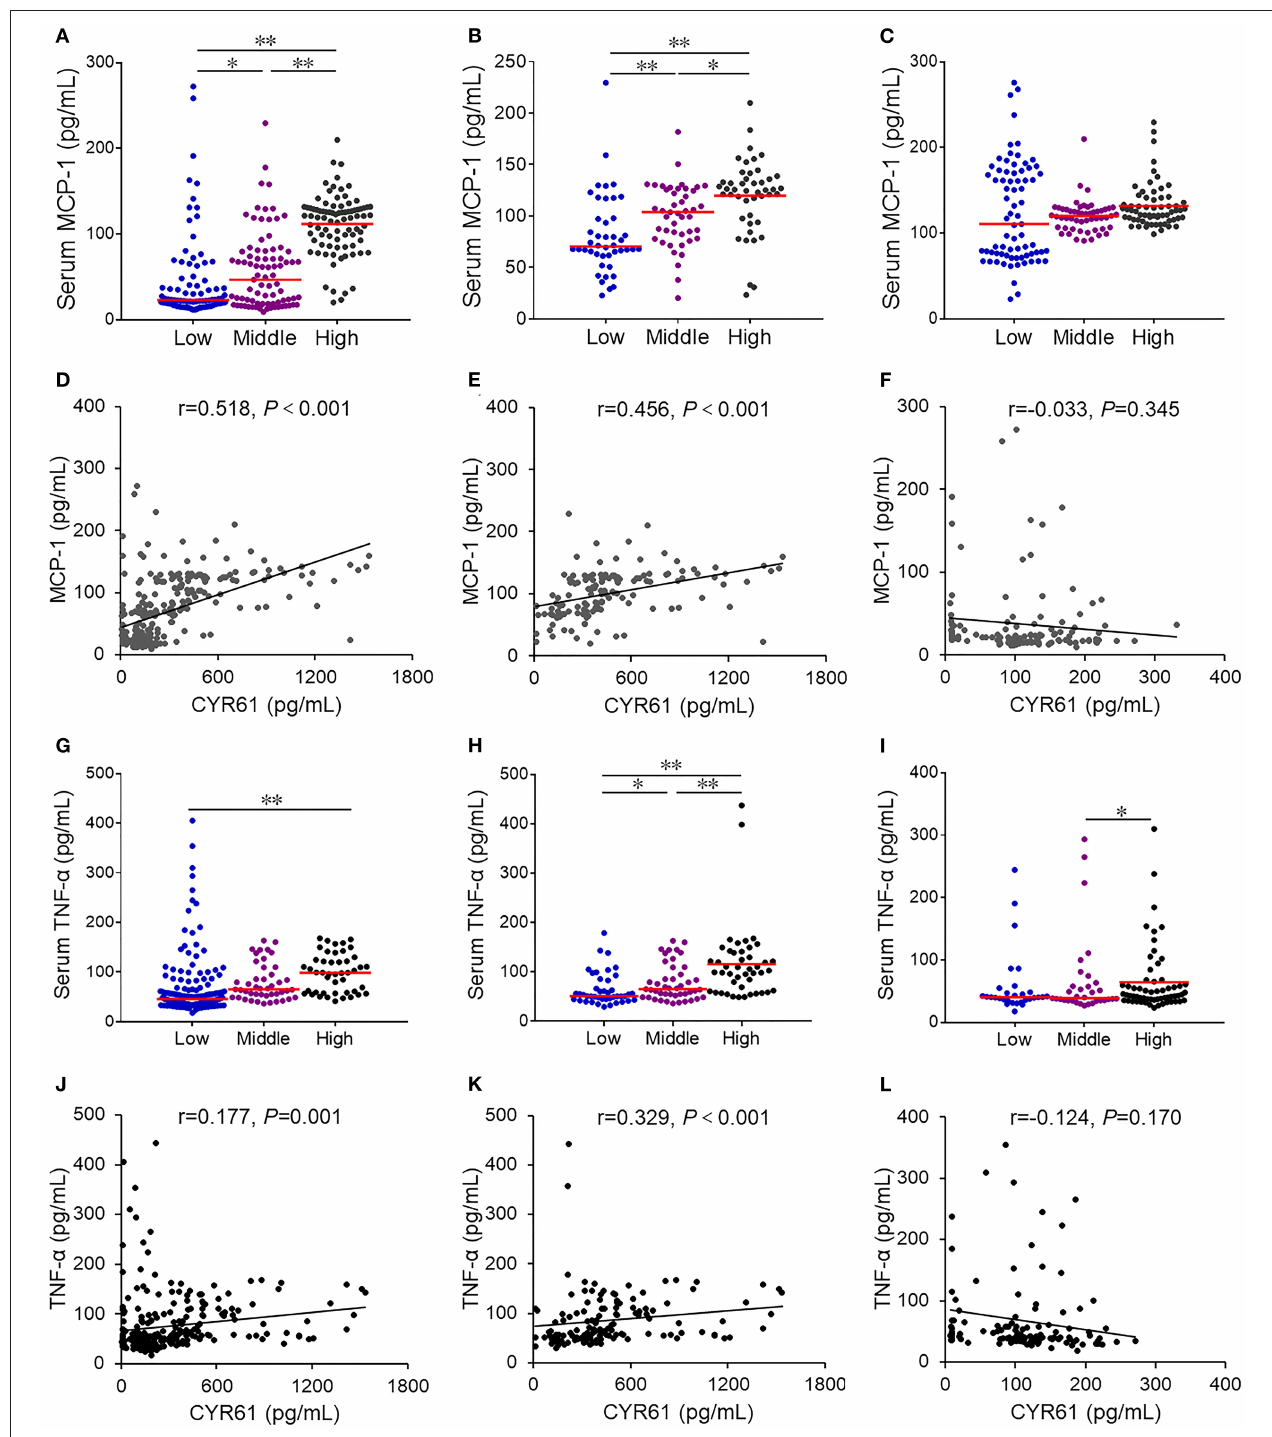
FIGURE 4 | The association of serum CYR61 level with serum inflammatory cytokines in COPD patients. Sera were collected from 150 COPD patients and 150 control subjects. Serum CYR61 and inflammatory cytokines were detected using ELISA. (A,D) Association between serum CYR61 and MCP-1 was analyzed among all subjects. (A) Serum MCP-1 was compared among subjects with different levels of CYR61. (D) Correlation analysis between serum CYR61 and MCP-1. (B,E) Association between serum CYR61 and MCP-1 was analyzed among COPD patients. (B) Serum MCP-1 was compared among COPD patients with different levels of CYR61. (E) Correlation analysis between serum CYR61 and MCP-1. (C,F) Association between serum CYR61 and MCP-1 was analyzed among control